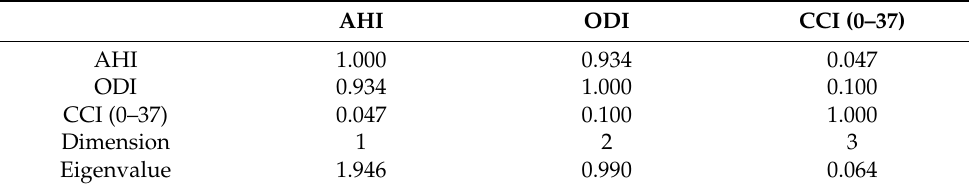
Table 3. Correlation-transformed variables.